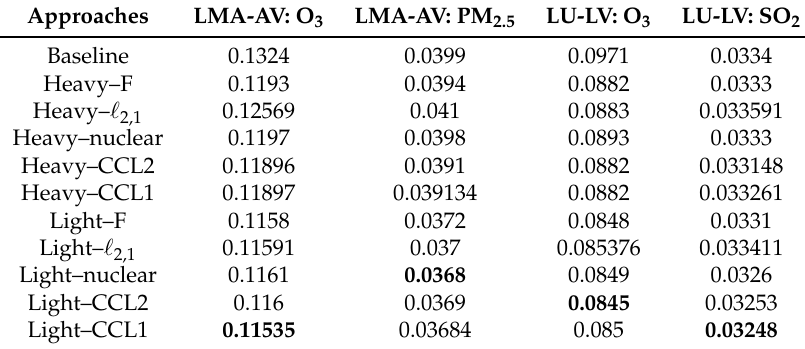
Table 2. Root-mean-squared error (RMSE) for all approaches and datasets. The best approaches are marked as bold.